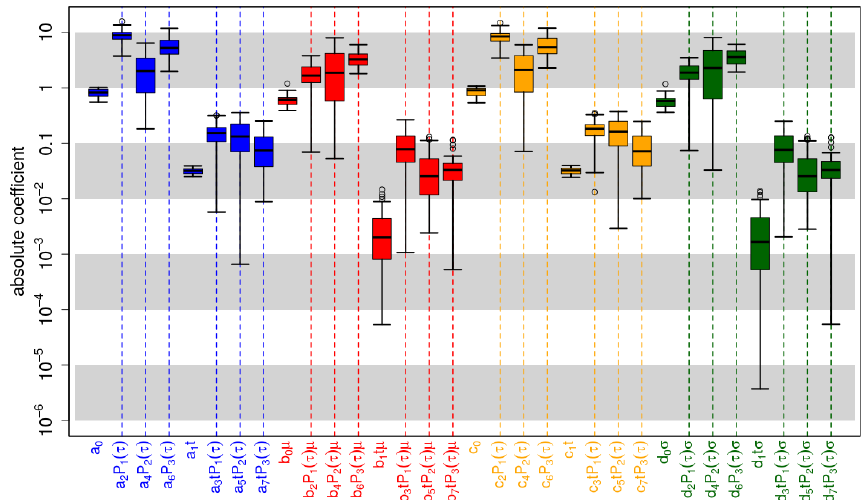
Figure A1. Coefficient estimates for recalibrating global mean 2m temperature of the MiKlip prototype system with a third-order polyno- mial lead time dependency for the unconditional and conditional bias and dispersion. Here, non-homogeneous boosting is not applied and all polynomials are orthogonalized; i.e., P 1 (τ),P 2 (τ),P 3 (τ) refer to the order of the corresponding polynomial. Colored boxes represent the IQR around the median (central, bold and black line) for coefficient estimates from the cross-validation setup; whiskers denote maximum 1.5 IQR. Coefficients are grouped according to correcting unconditional bias (blue), conditional bias (red), unconditional dispersion (orange) and conditional dispersion (green). Values refer to coefficients a 0 ,b 0 ,c 0 ,d 0 ,...,a 6 ,b 6 ,c 6 ,d 6 and not to the product between these coeffi- cients and the corresponding predictors (e.g., a 2 P 1 (τ) refers to a 2 ). Vertical dashed bars highlight coefficients related to lead-time-dependent terms.